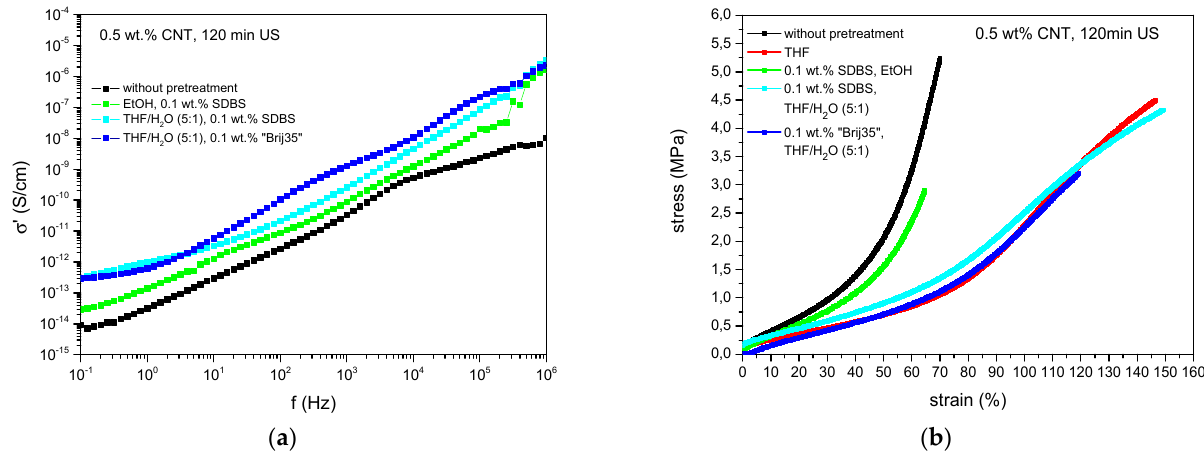
Figure 7. Composites with CNTs pretreated with surfactants, ( a ) dielectric conductivity and ( b ) stress–strain analyses.